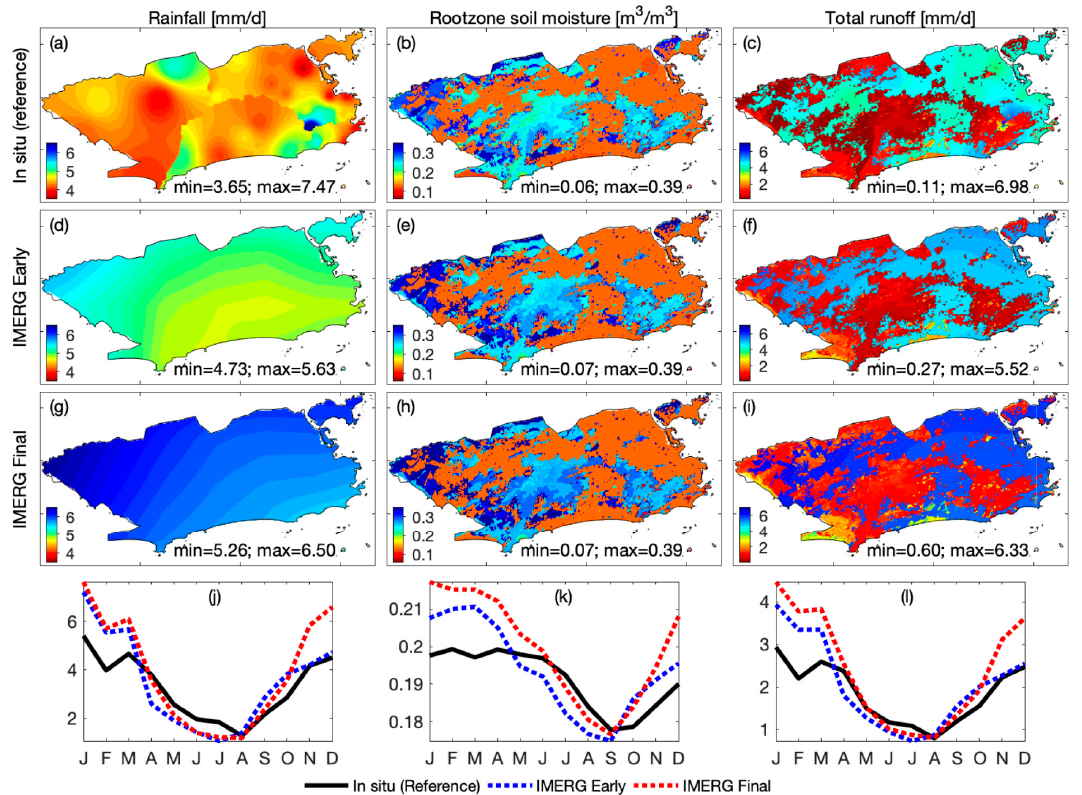
Figure 4. Spatially distributed rainfall, rootzone soil moisture (RZSM) and total runoff (TR) averaged over 2001–2019 wet seasons derived from the experiments using ground-based ( a – c ), IMERG Early ( d – f ) and IMERG Final ( g – i ) rainfall estimates. Spatially-averaged monthly climatology time series are shown in the bottom ( j – l ).